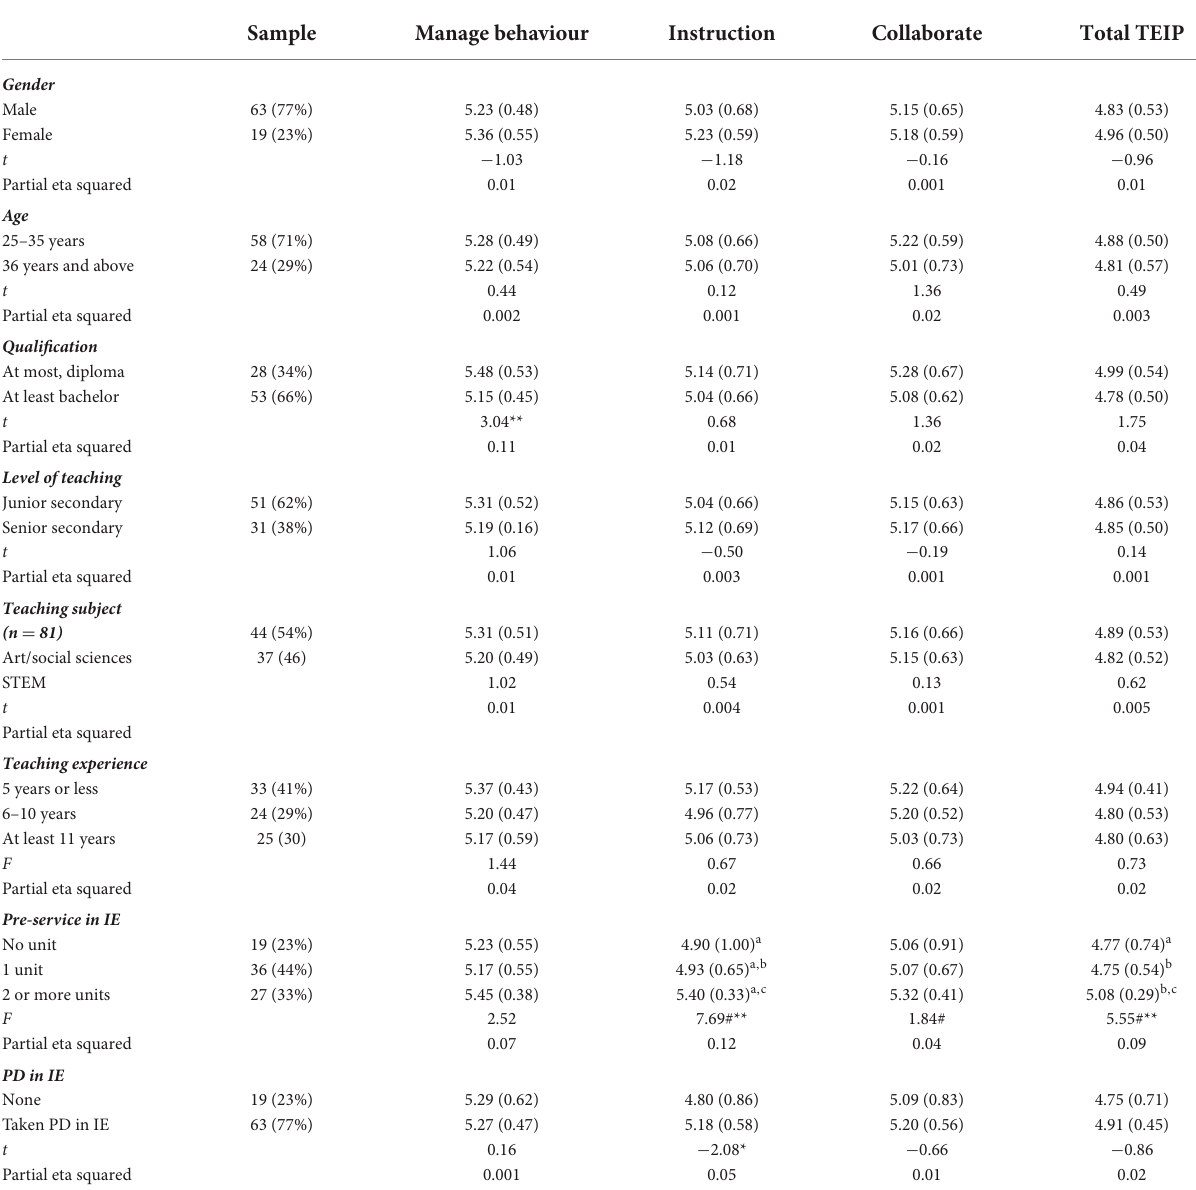
TABLE 1 Demographic characteristics and its association with self-efficacy. Sample Manage behaviour Instruction Collaborate Total